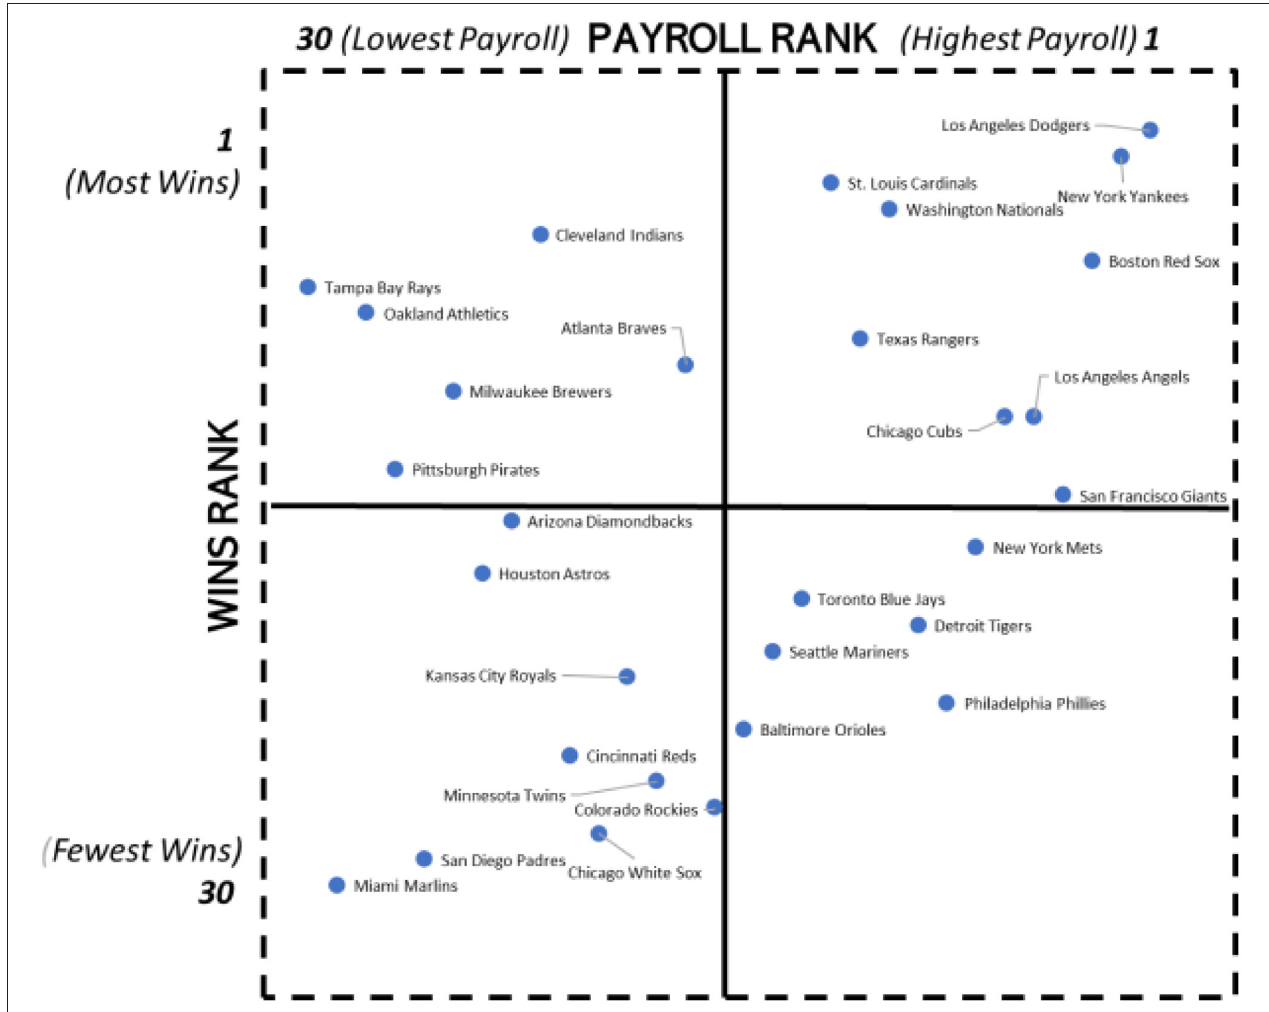
FIGURE 6 | Quadrant analysis of MLB payroll rank and regular season win percentage ranks: 2011–2019.